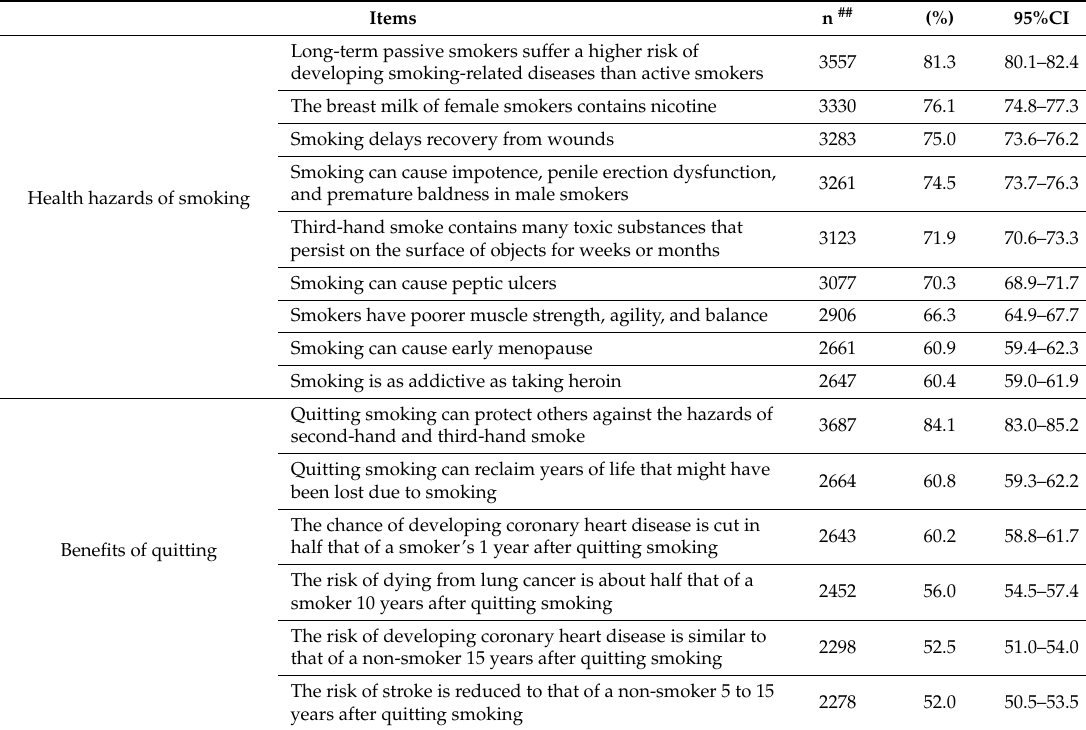
Table 4. Nurses who correctly answered the questions related to the health hazards of smoking and the benefits of quitting (N = 4413) #